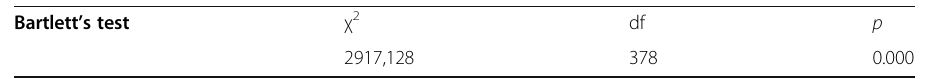
Kaiser Meyer Olkin